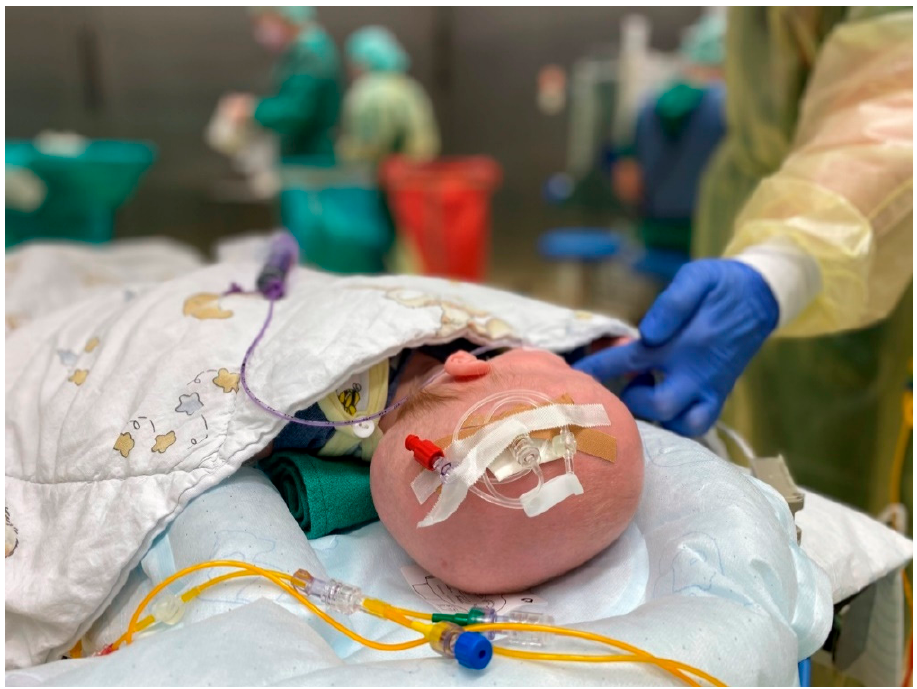
Figure 3. Use of an underbody, forced-air, warming blanket and insulation cover to efficiently prewarm a 4-month-old child.